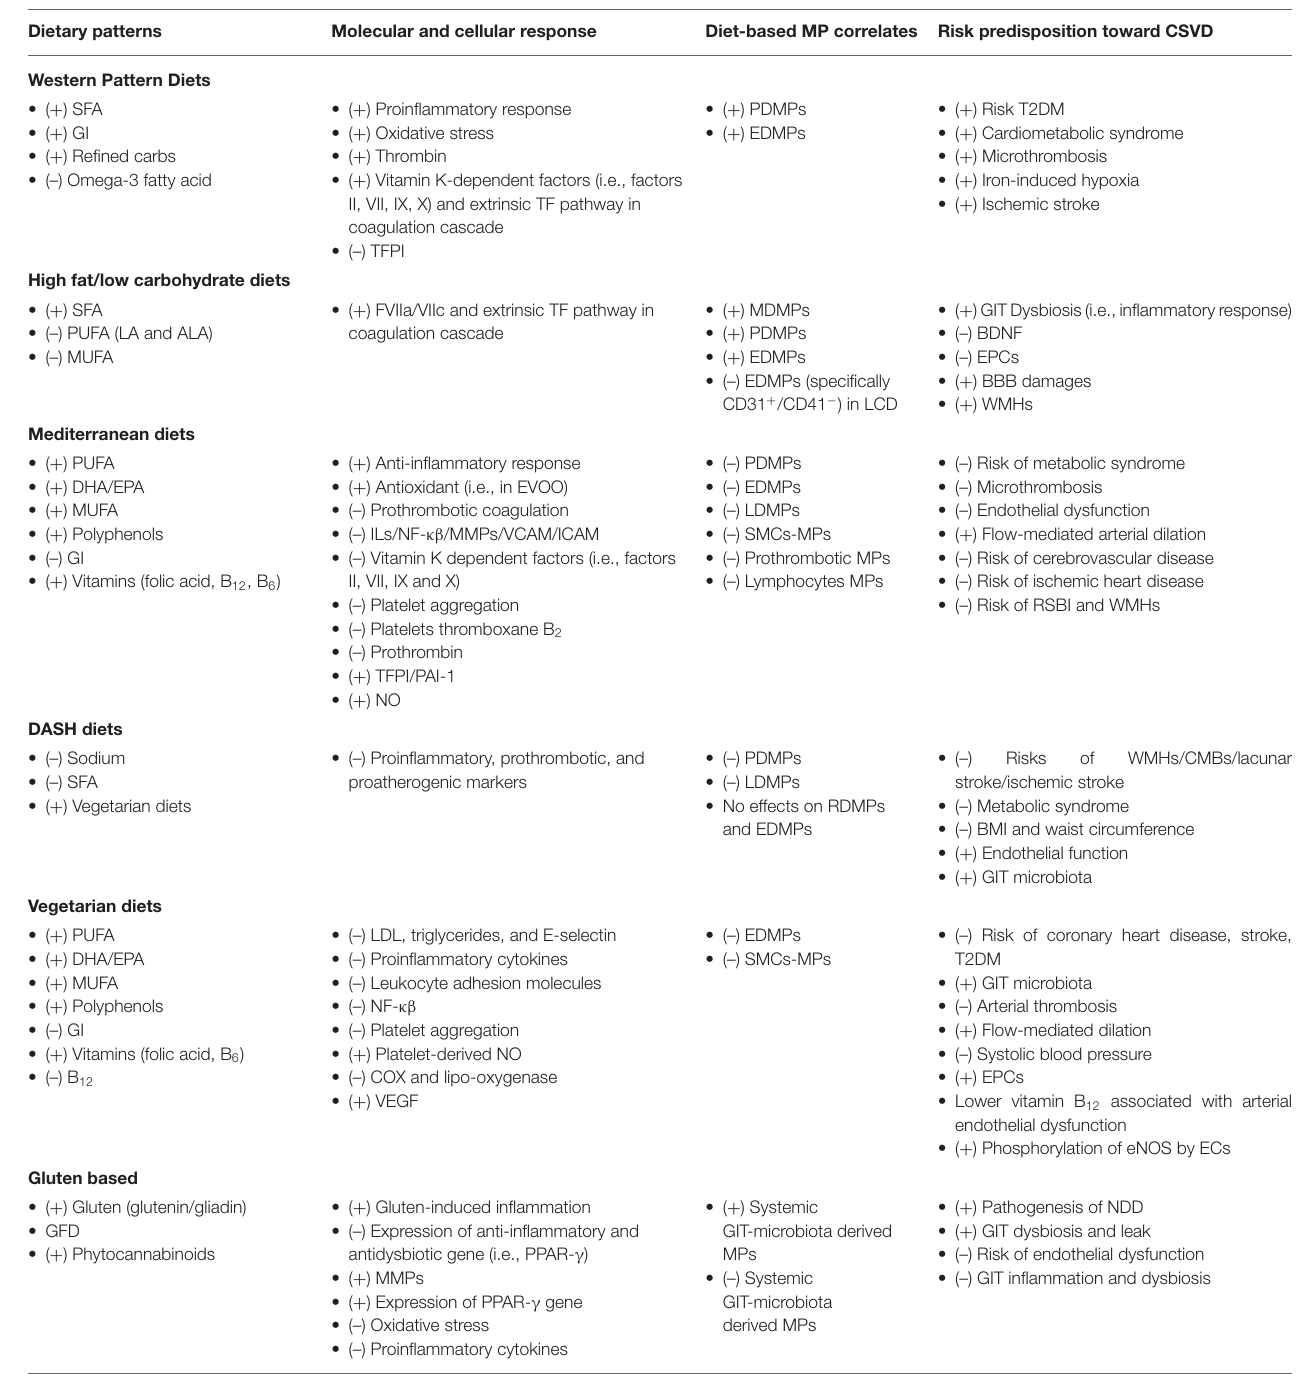
TABLE 4 | Summary of the role of dietary patterns, its molecular/cellular response, MP release, and risk predisposition toward CSVD. Dietary patterns